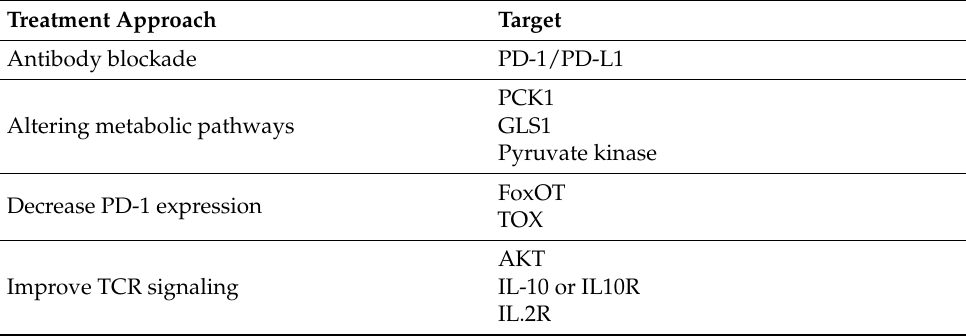
Table 3. Treatment approach and its targets to reverse T-cell exhaustion. Treatment